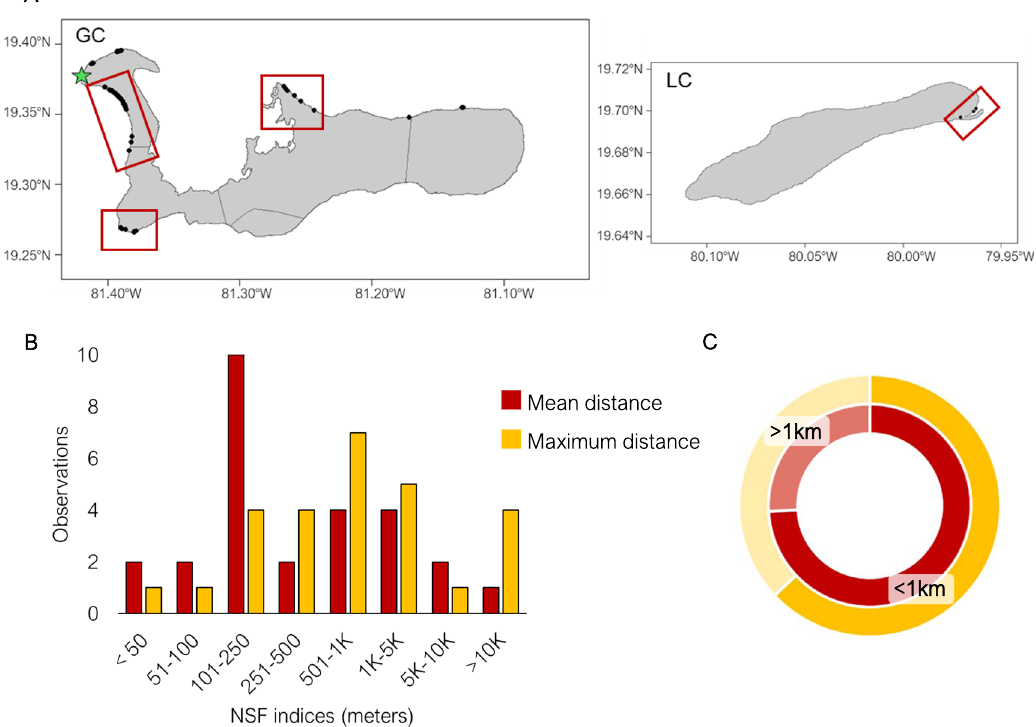
Fig. 4 Nest-site fi delity. A Map detailing the geographic locations of the 149 nests laid by the 43 wild females (black dots) and the CTF (green star). Red rectangles indicate the major nesting sites in Grand Cayman and Little Cayman. B Distance between nests (Nest-site fi delity) of wild females laying more than 3 clutches per season ( n = 27 between nest distances) based on geographic coordinates of nests. Red shows the mean distance between consecutive nests, while yellow shows the distance between the two most distant nests of the same season. Most females lay nests within a very short distance as can be appreciated in the pie chart in C , showing the percentage of wild females nesting within 1 km vs. more than 1 km.